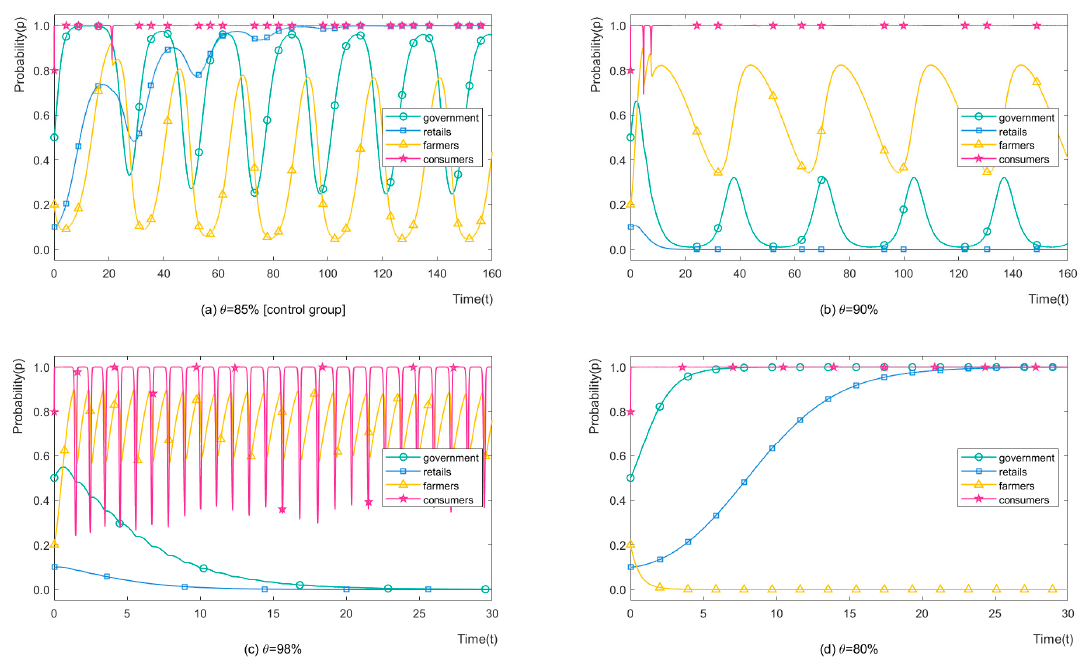
Figure 6. The strategy evolution process of stakeholders with different θ .